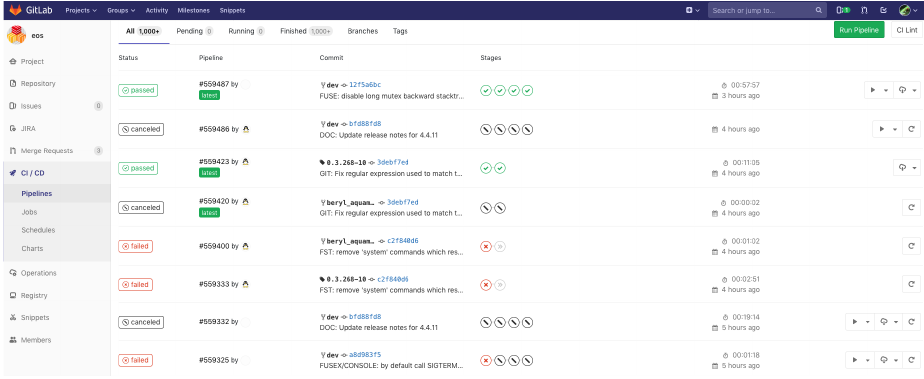
Figure 6. EOS Gitlab CI